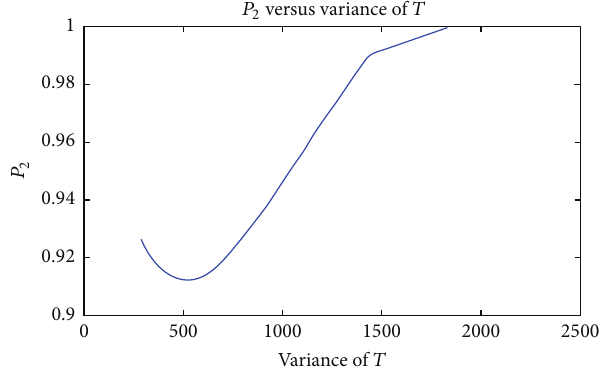
Figure 5: Change of 𝑃 2 against 𝜎 𝑇2